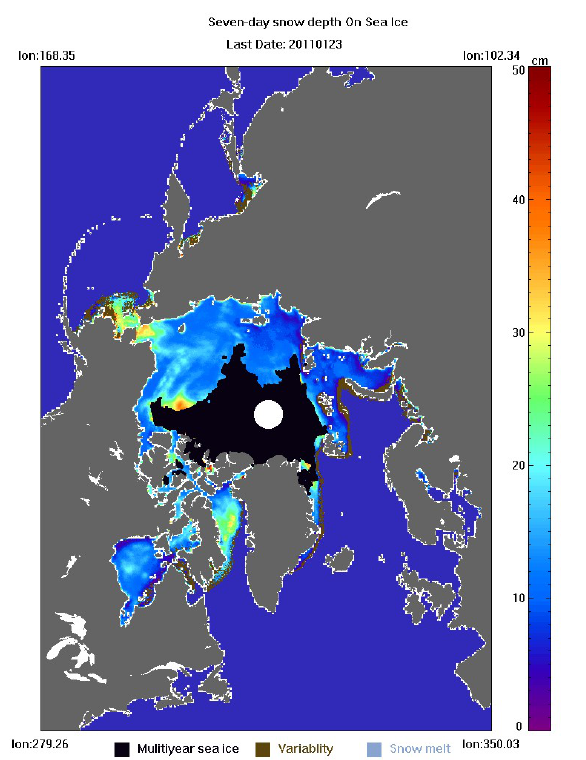
Figure 3. The snow depth of MWRI on January 23,